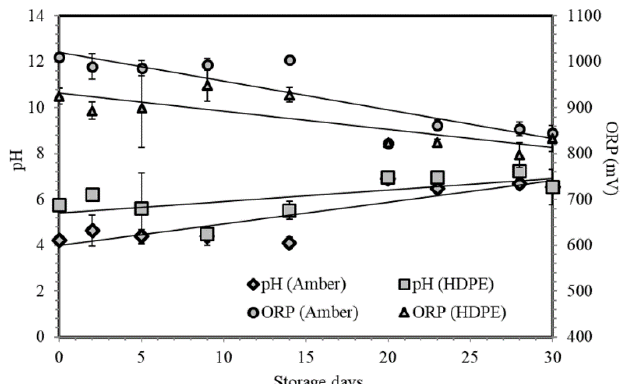
Figure 5. The pH and ORP distribution of ESW stored in both bottles throughout the 30-day storage period.